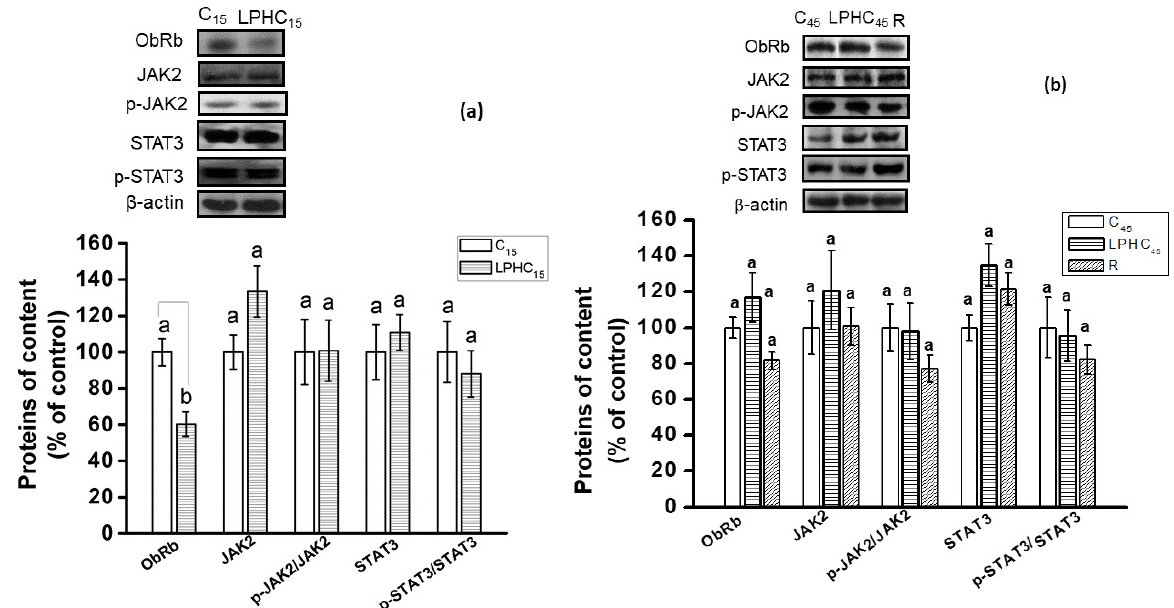
, LPHC , and R groups (b). Data are expressed as 45 45 vs 15 Figure 3. Content of SOCS3 (a), NPY (b), and POMC (c) in the hypothalamus of the C and LPHC 15 15